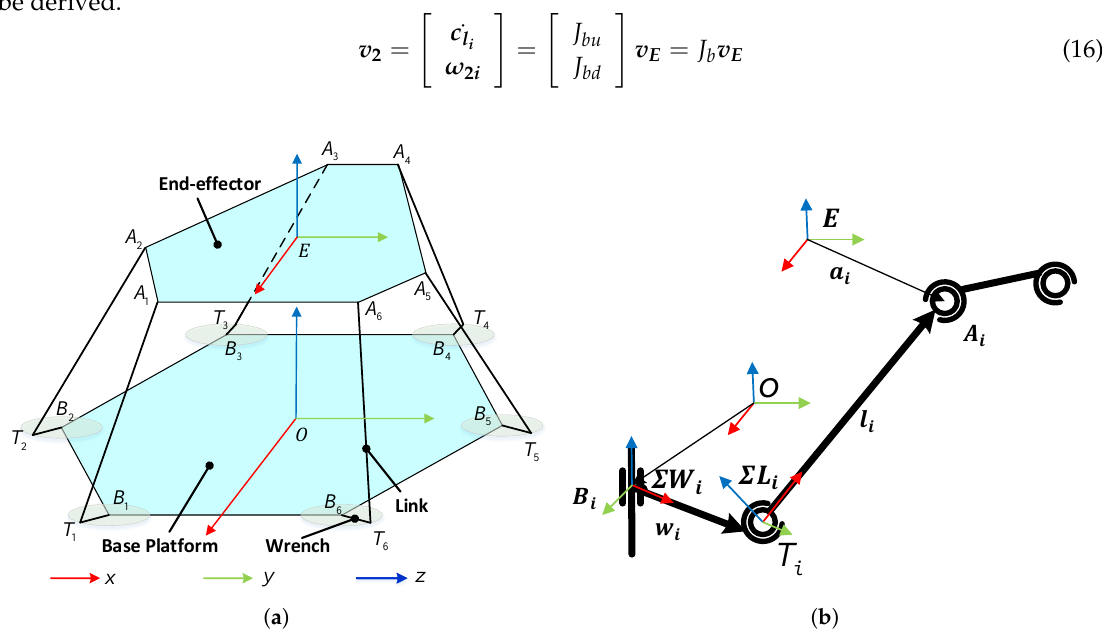
Figure 1. ( a ) The sketch of 6-RSS parallel robot, ( b ) Single serial